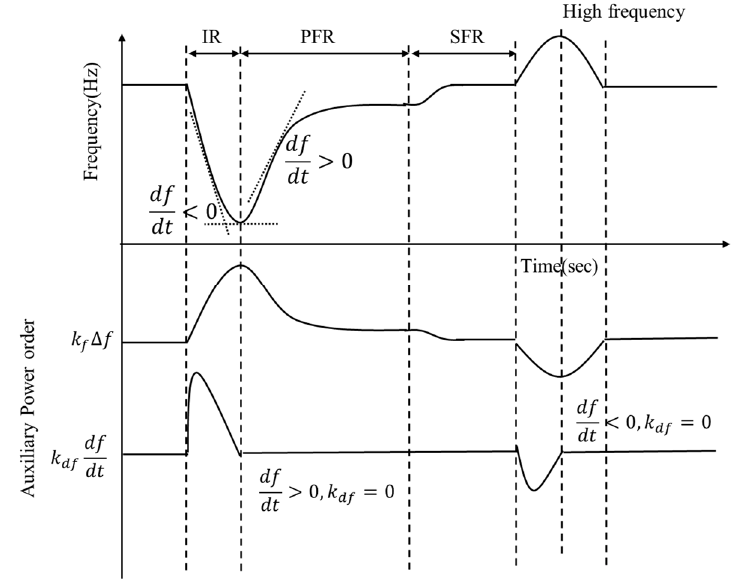
Figure 1. Frequency response characteristic.